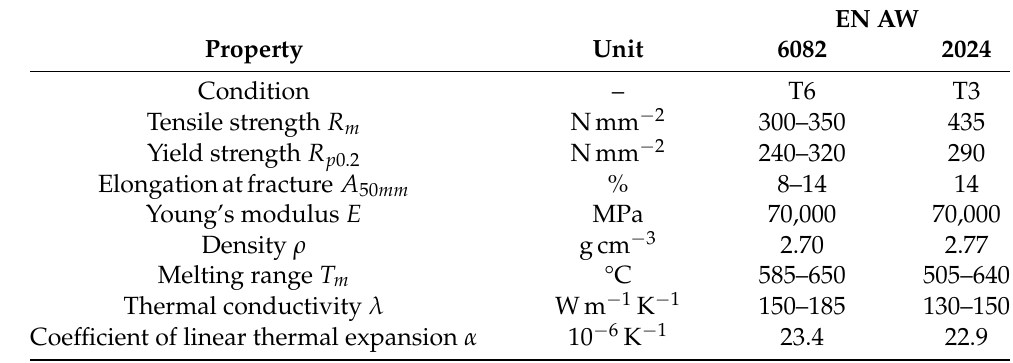
Table A1. Selected thermal and mechanical properties of the aluminum EN AW-6082-T6 and EN AW-2024-T3 [32,34,54].